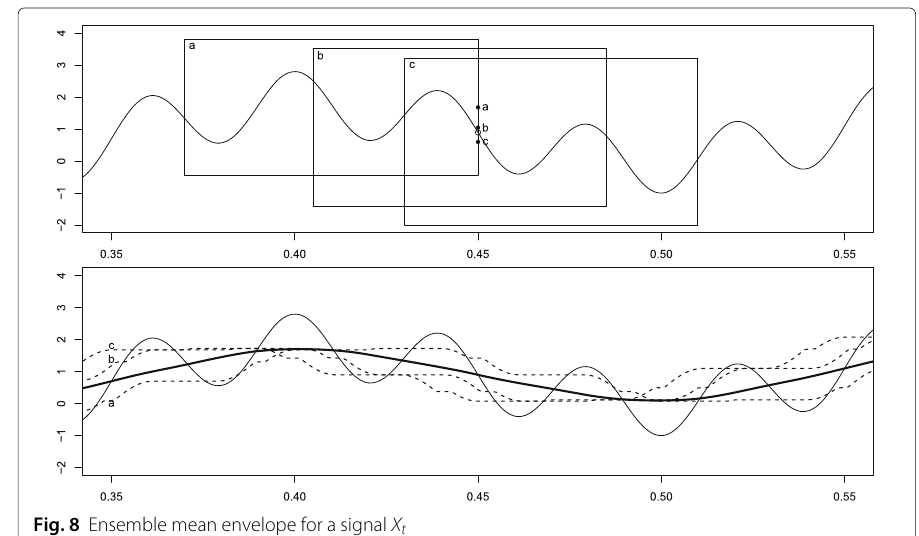
Fig. 8 Ensemble mean envelope for a signal X